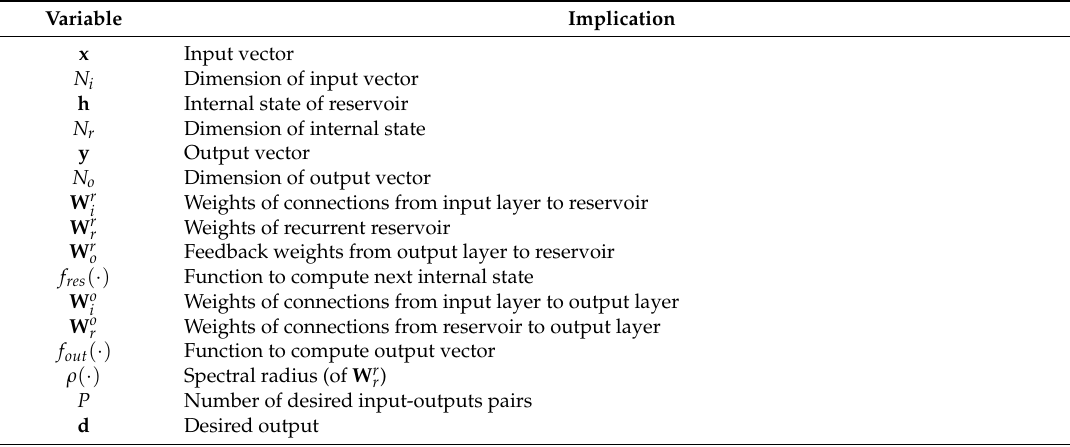
Table 1. Notation of this